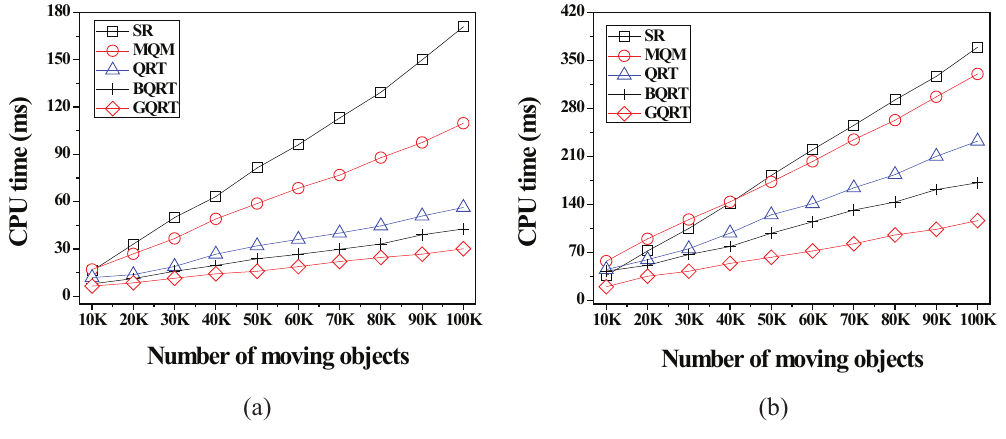
Figure 12. CPU-time vs . number of moving objects. ( a ) Uniform ; ( b ) Skewed